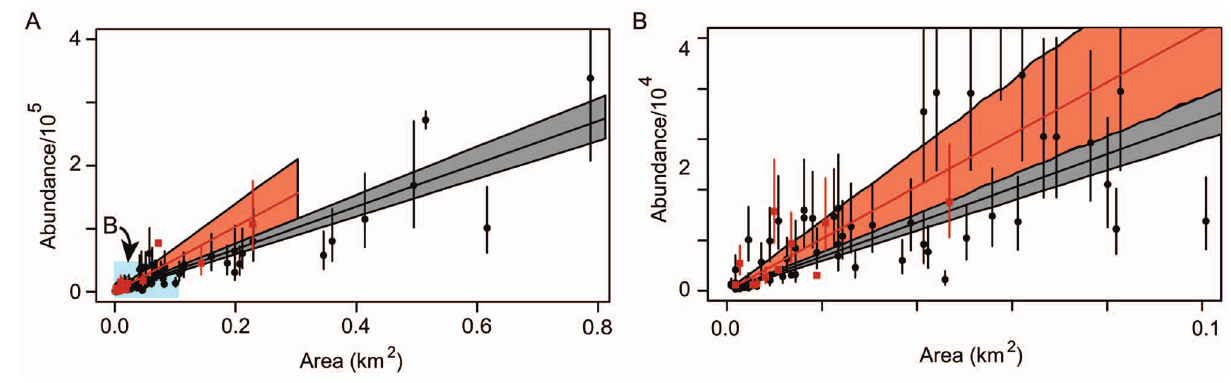
Figure 2. Colony abundance vs. guano stain area. (A) Colony abundance (and 95 th percentile confidence intervals; as reported by [7] as a function of the area identified as guano in the Landsat-7 survey (black circles = continental Antarctica, orange squares = Antarctic Peninsula), with best-fitting Poisson regression model (and associated 95 th percentile prediction envelop; gray-shaded envelop = continental Antarctica, orange- shaded envelop = Antarctic Peninsula). (B) Zoomed in portion shown as blue box in Panel A.